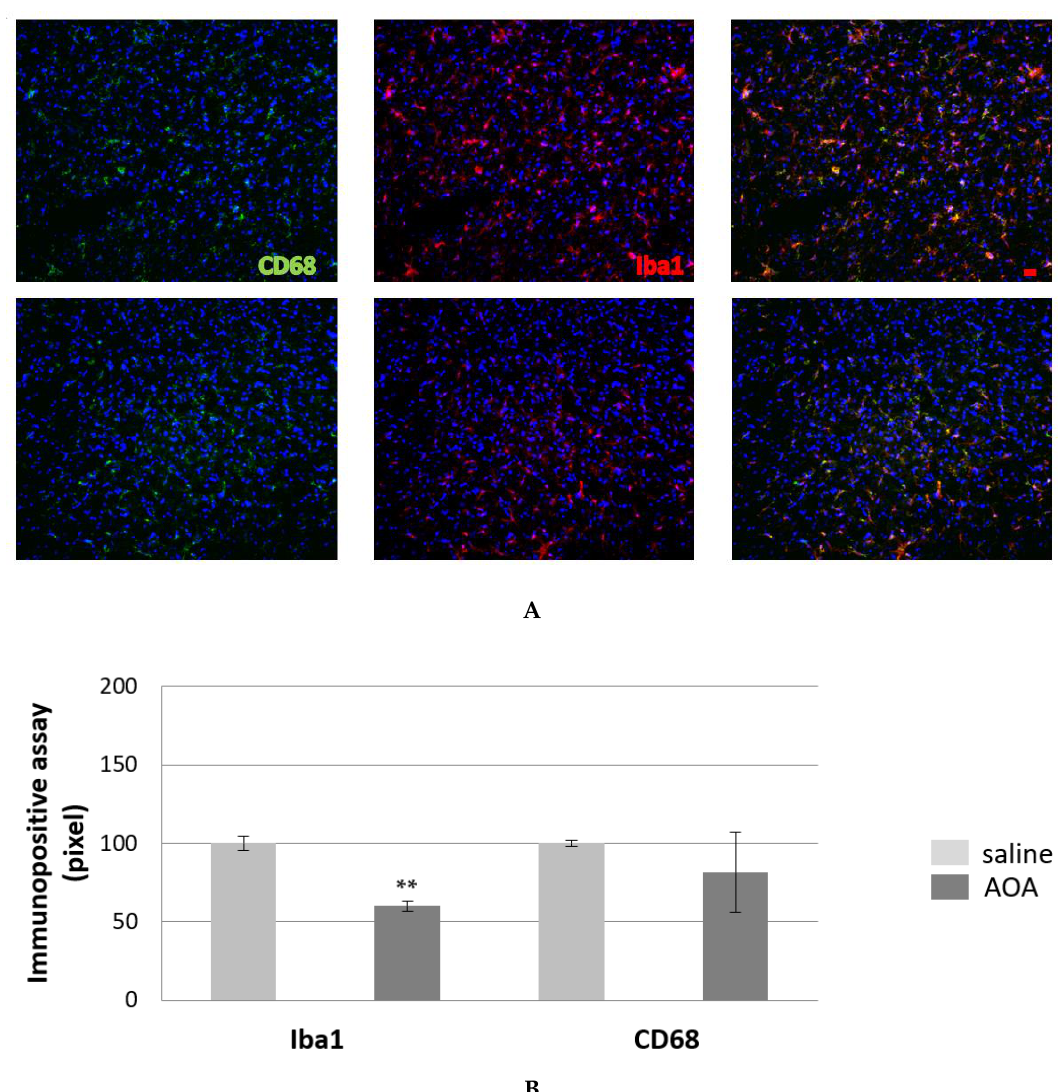
Figure 4. Microglia (IBA1) and reactive microglia (CD68) in the spinal cord SOD1G93A treated with saline ( A , upper) and AOA-treated mice ( A , bottom). ( B ) The immunopositive assay showed a decrease of microglia in AOAA-treated mice compare to those treated with saline. The mean of the pixels was quantified in three fields of the ventral horn spinal cord in AOA-treated mice ( n = 3) and saline-treated mice ( n = 3). Data are presented as a percentage of normalised to saline values as the mean ± SEM. The values were compared by using Student’s t -test with ** p < 0.01 (B). Scale bar = 20 microns.